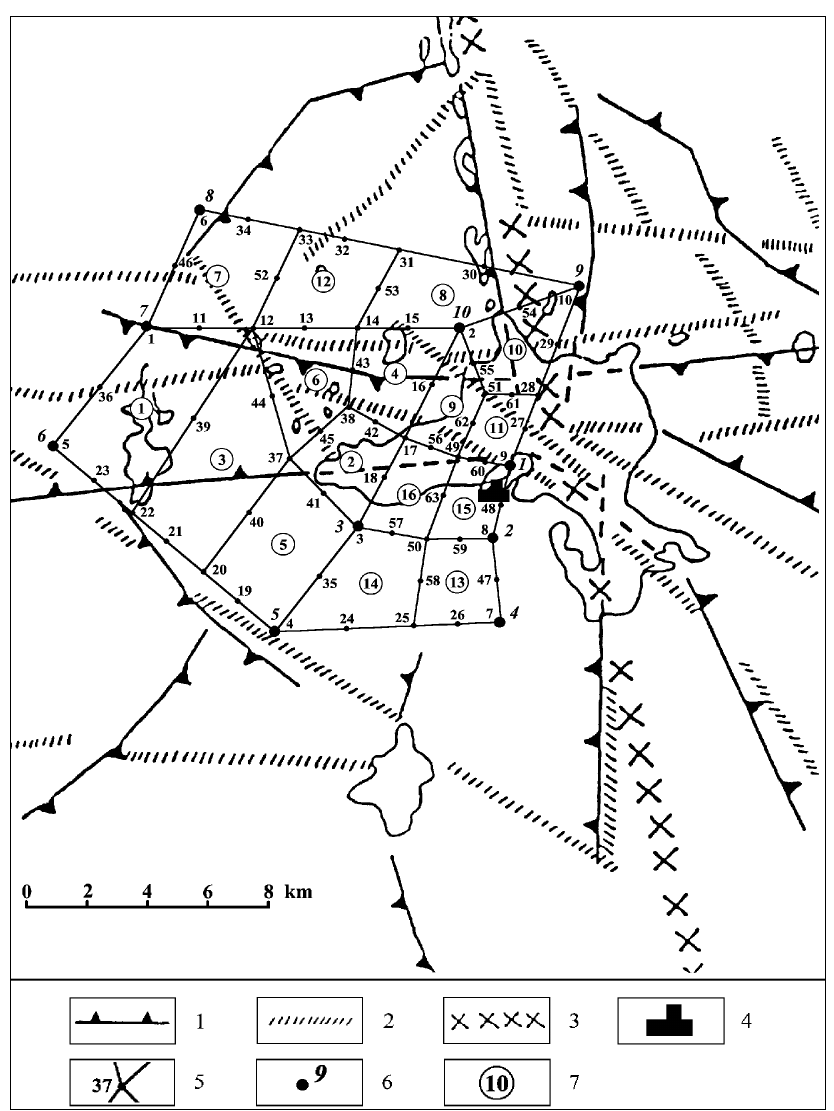
Fig 1. The location scheme of the tectonic breaks and network of the finite elements at the Ignalina nuclear power plant. Tectonic breaks (according to I. Juknelis, V. Marcinkevi č ius, I. Šeštokas and A. Šliaupa) discovered by: 1 – seismic survey, 2 –